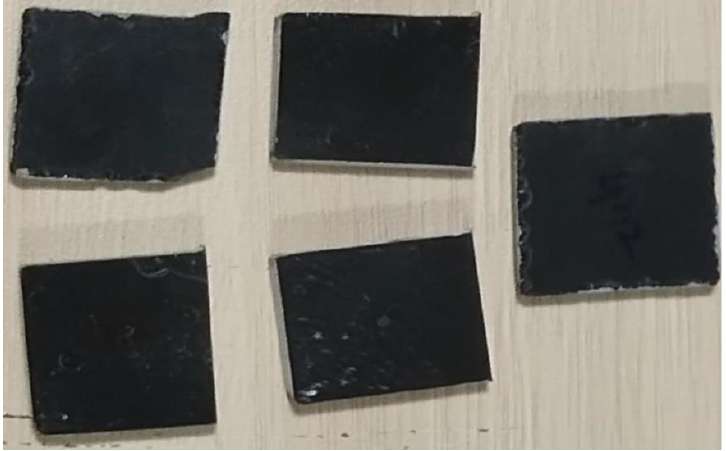
Figure 1. Nanocomposite samples prepared for erosion test